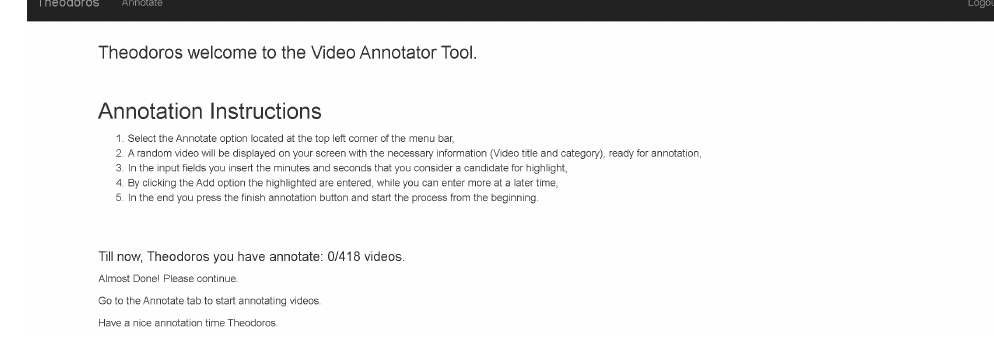
Figure 2. Video Annotator Tool Home